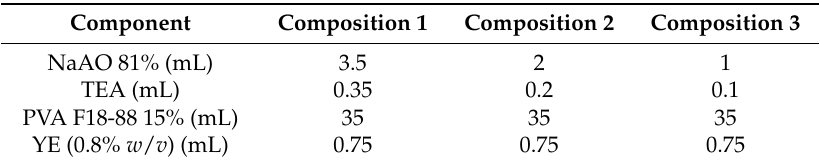
Table 1. The three different chemical solutions of Biophotopol which were analyzed. NaAO: sodium acrylate; PVA: poly(vinyl alcohol); TEA: triethanolamine; YE: yellowish